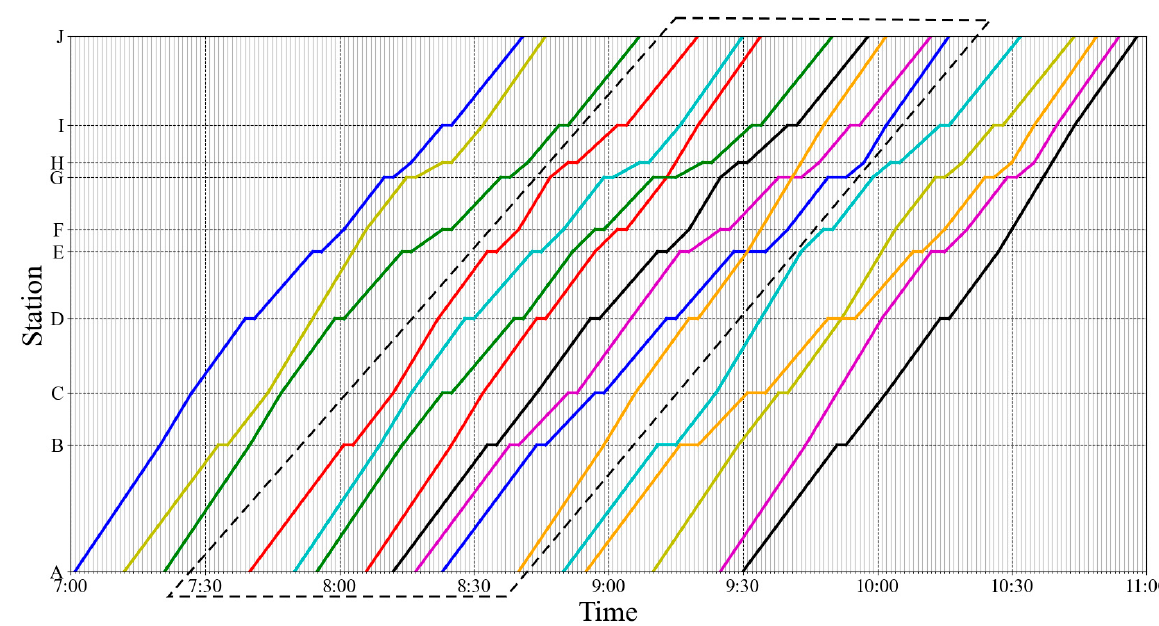
Figure 7. Time–distance diagram of trains in the experiment.